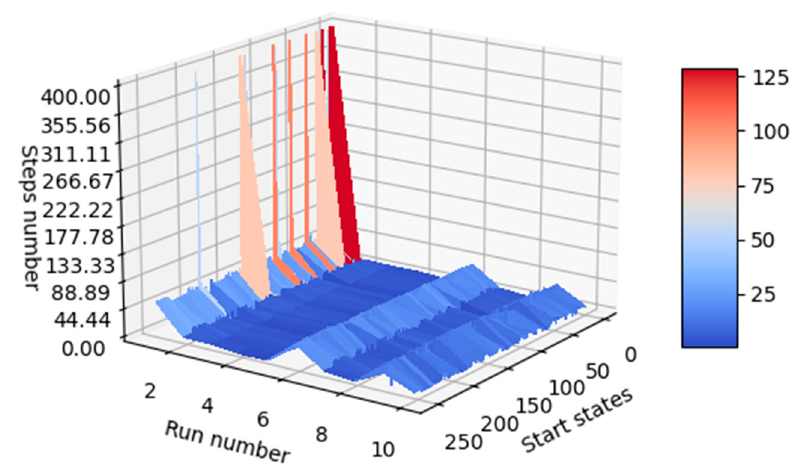
Figure 15. Comparison of the performance of newly trained agents.